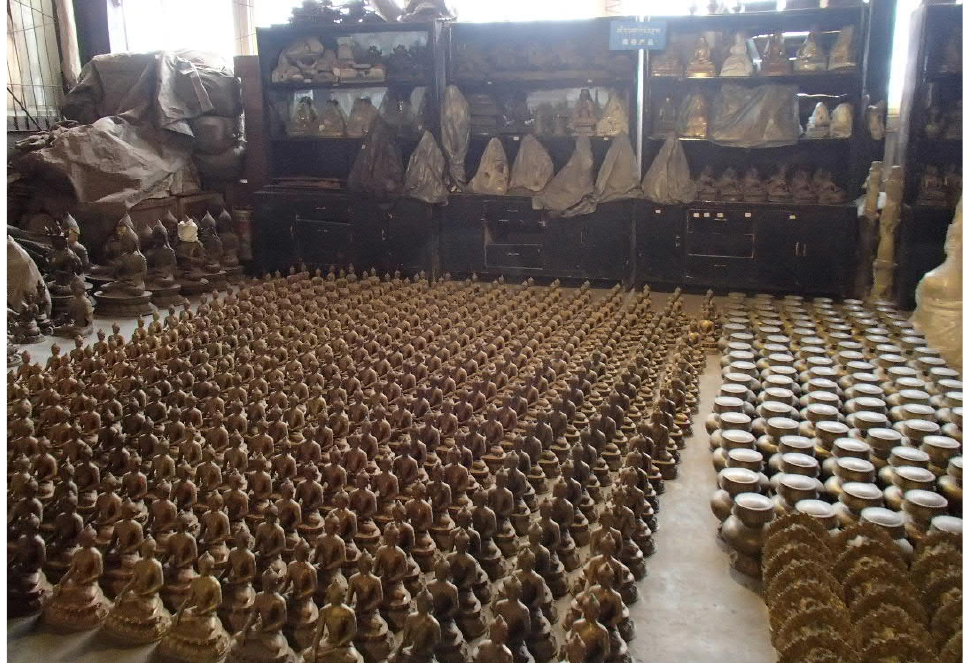
Figure 2. Statues and ritual vases in the factory